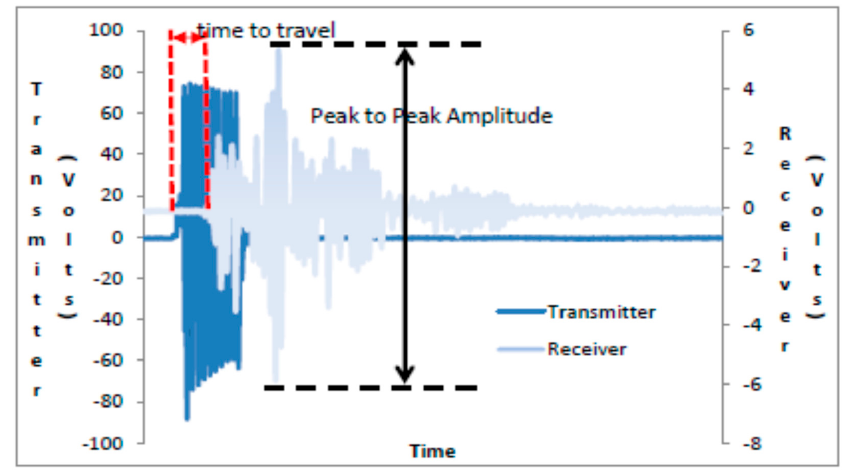
Figure 1. Linear ultrasonic test using ultrasonic pulse velocity (UPV) and peak to peak amplitude (PPA) in time-domain recorded from the transmitter and receiver.